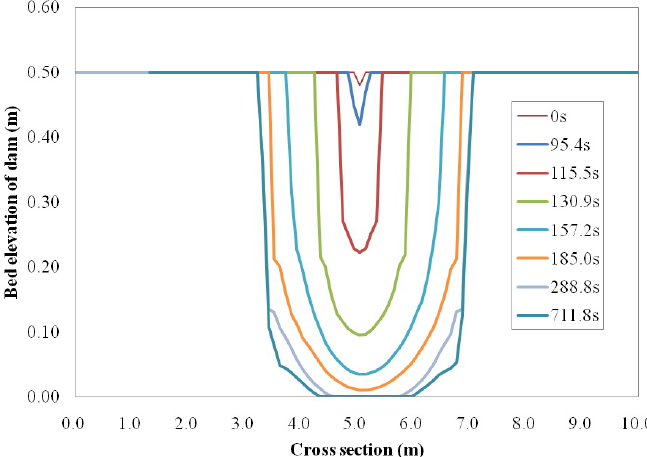
Figure 10. Simulated breach width and depth changes with no